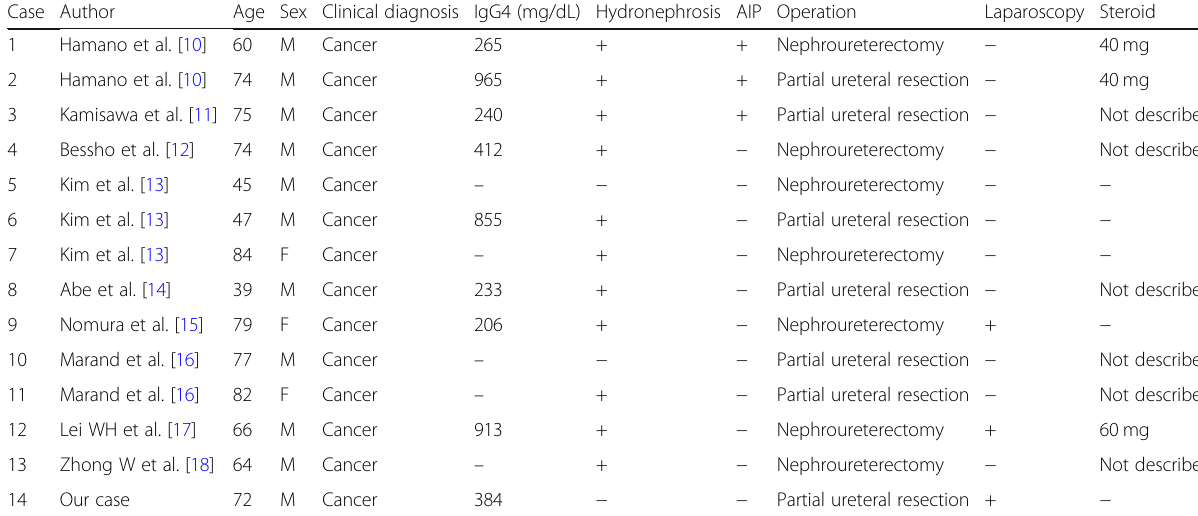
Table 1 Summary of IgG4-related disease in the